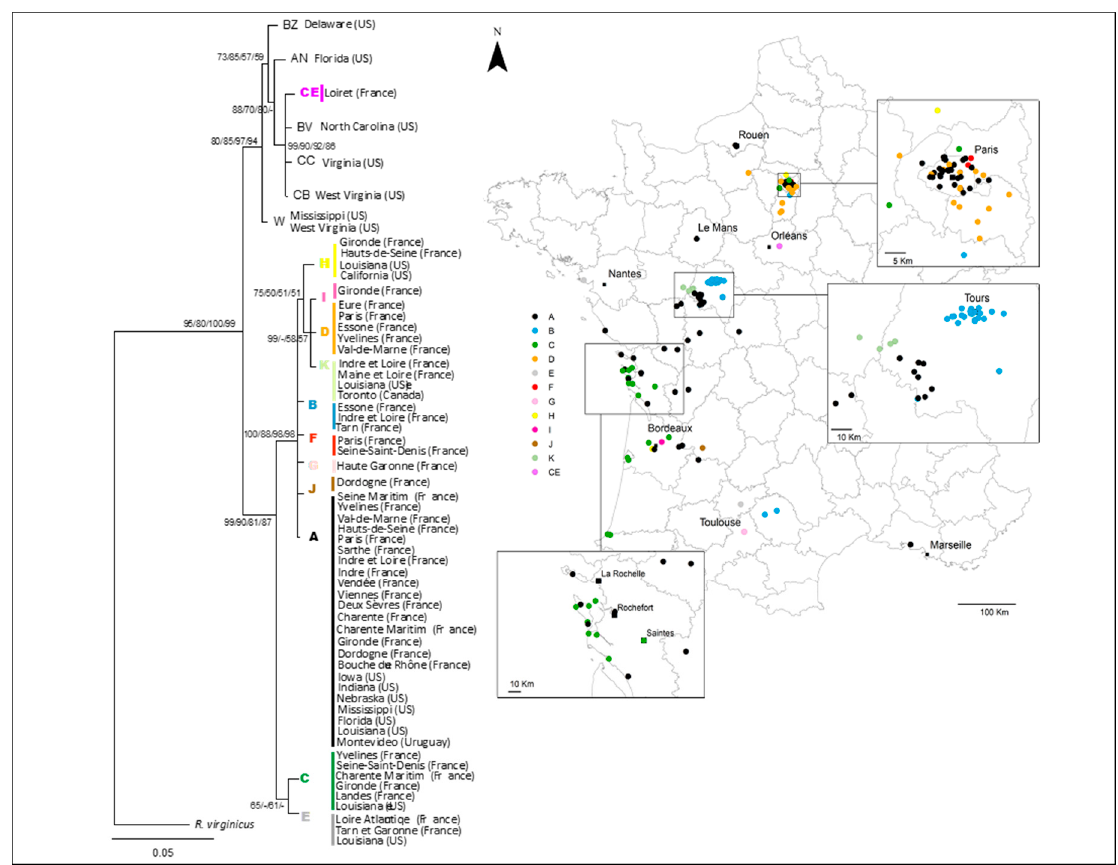
Figure 1. Phylogenetic tree of Reticulitermes flavipes mtDNA haplotypes obtained using Bayesian inference. Haplotypes are indicated by colored letters and dots. The map shows the geographical distribution of the samples.